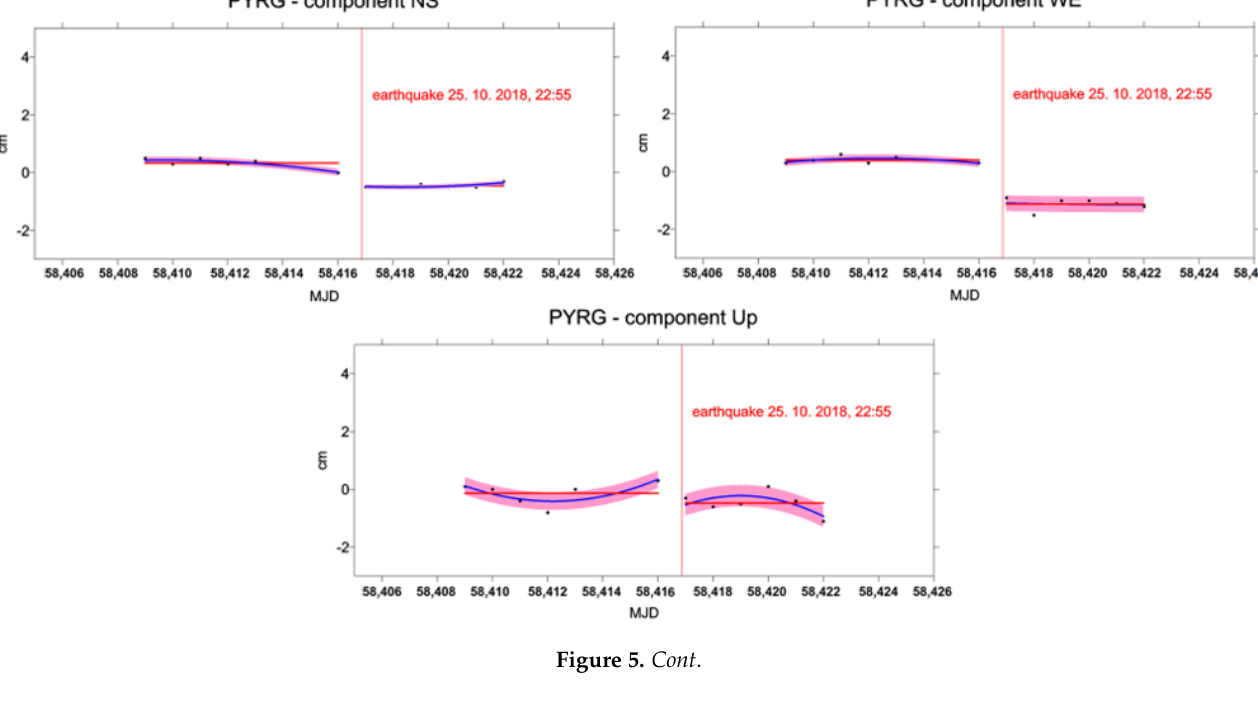
Figure 4. Geographical distribution of stations PYRG, STRF, and ZAKY, associated with a vector of horizontal shift and 2.95 sigma errors (RMSE 2nd approach).